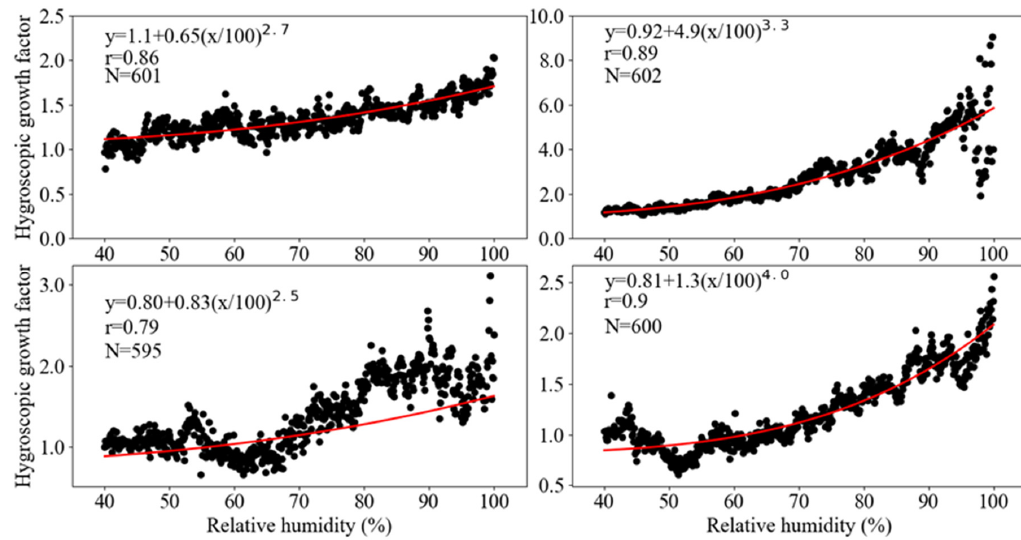
Figure 9. Correlationship between the hygroscopic growth factor and the relative humidity across four seasons over the Sichuan Basin.